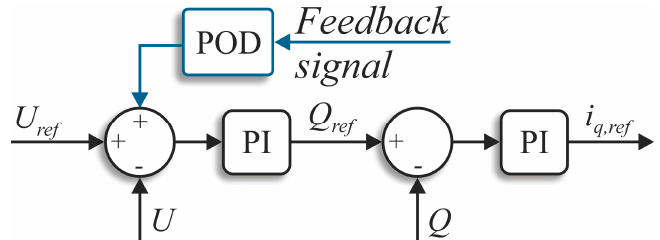
Figure 8. POD modulating the bus voltage reference.